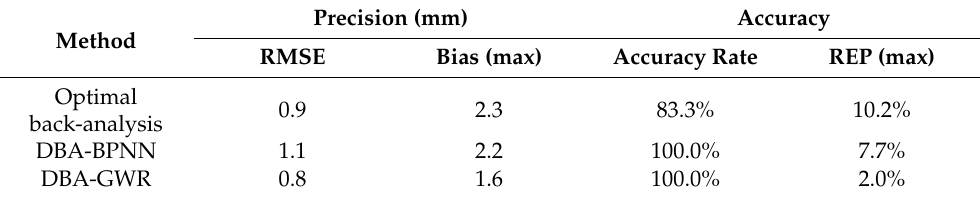
Table 6. Precision and accuracy of equivalent parameters obtained with different